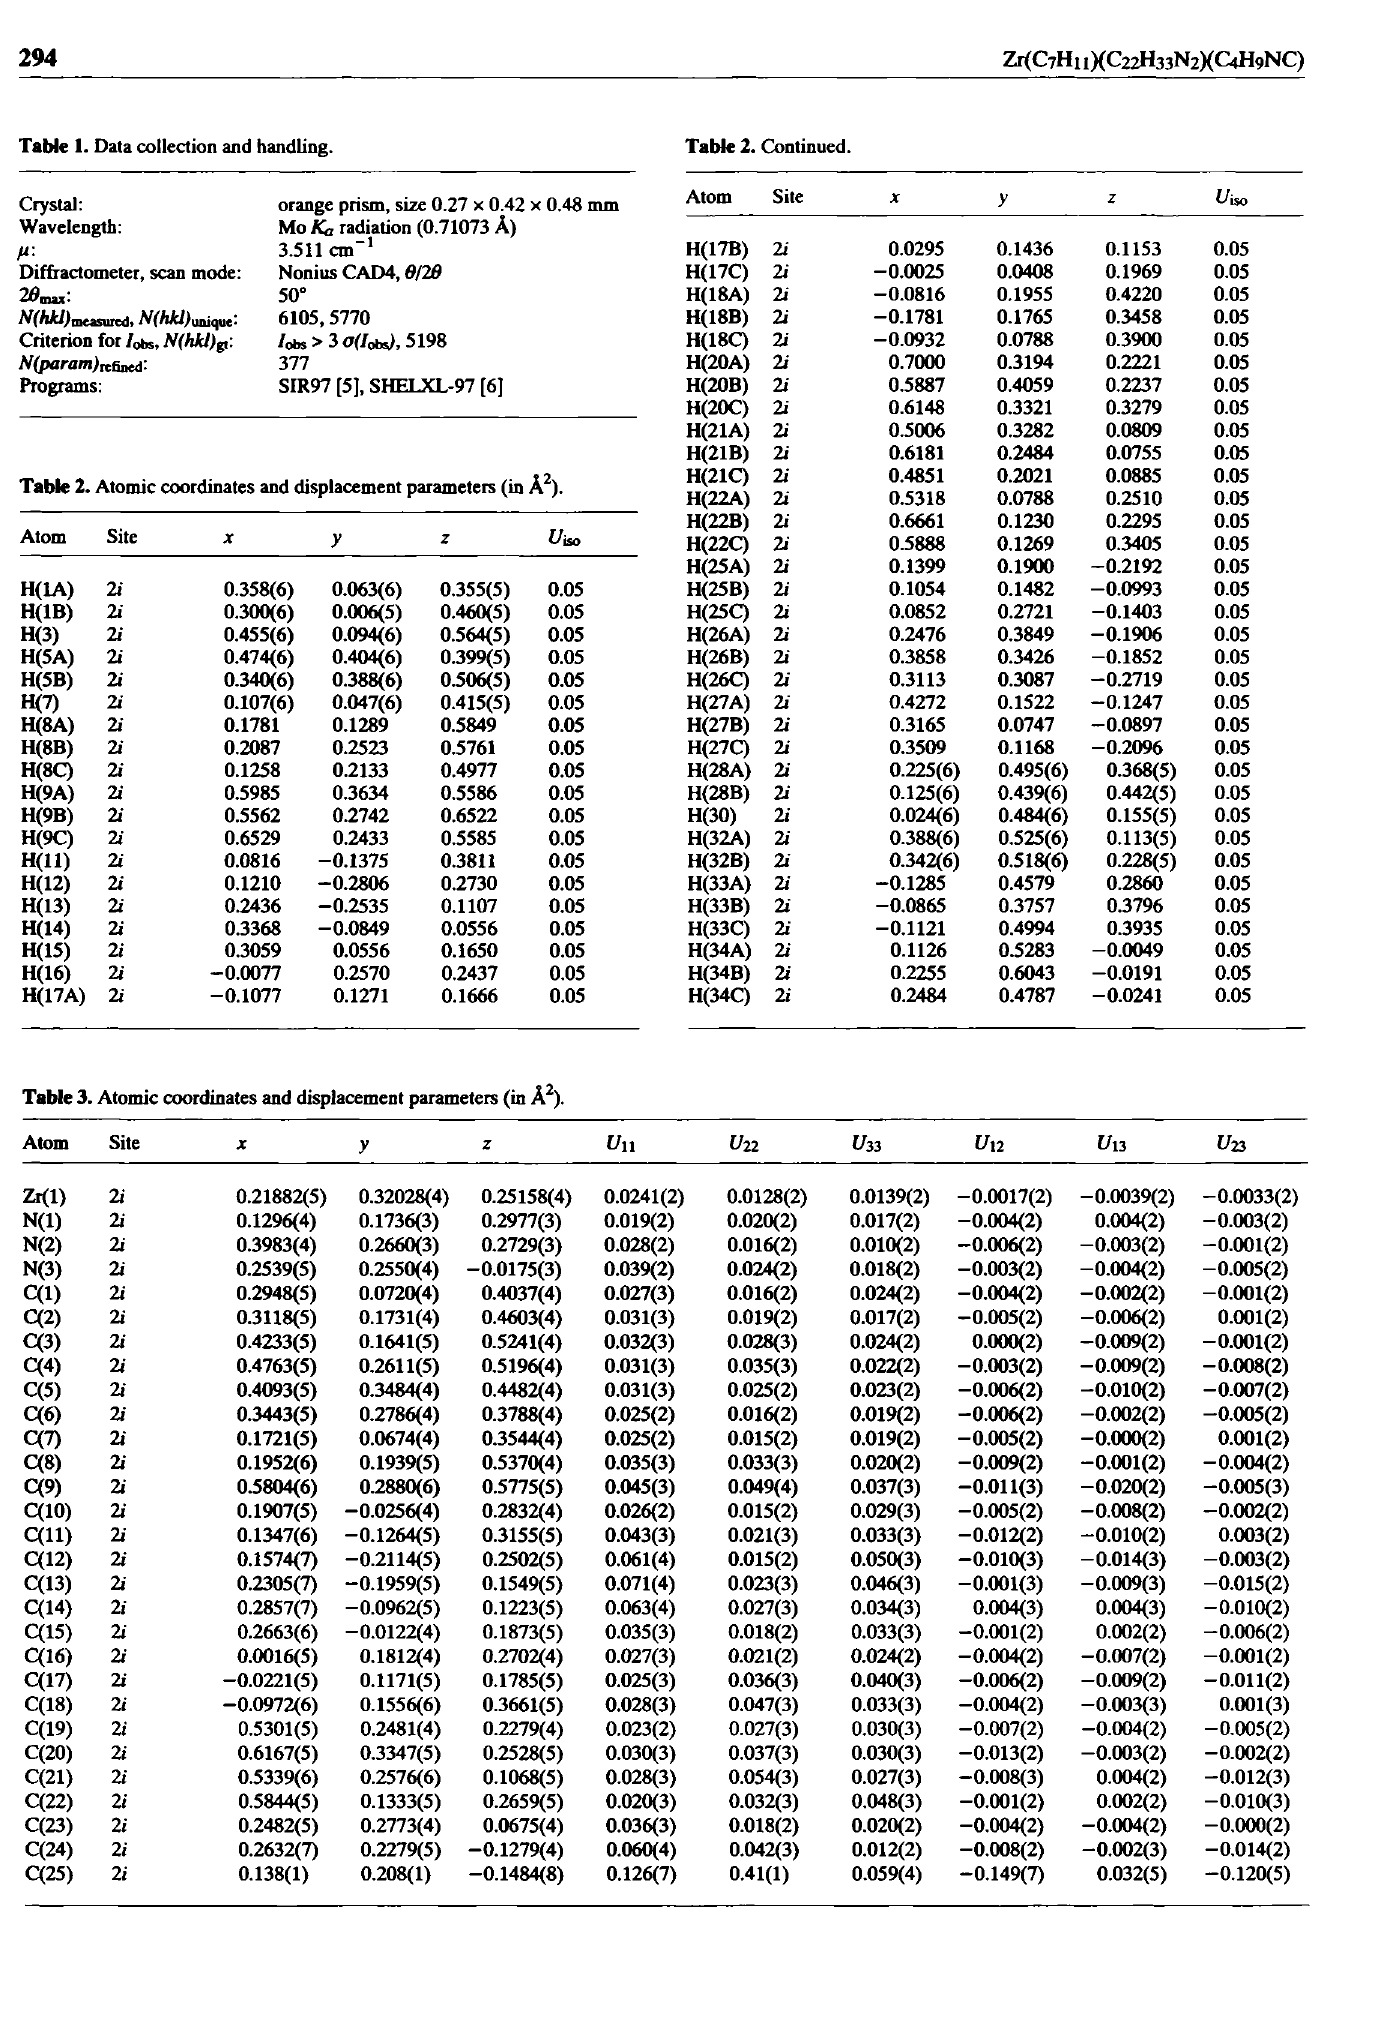
Table 2. Atomic coordinates and displacement parameters (in Ä 2 ).